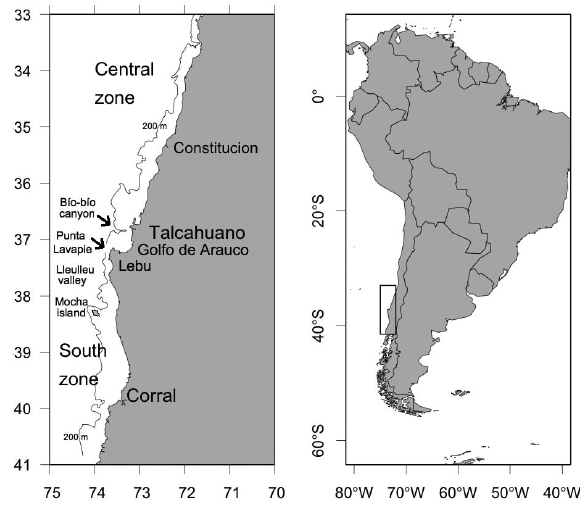
Fig . 1. – Study area off central-southern Chile; specimens of Stran- gomera bentincki were sampled in Talcahuano and